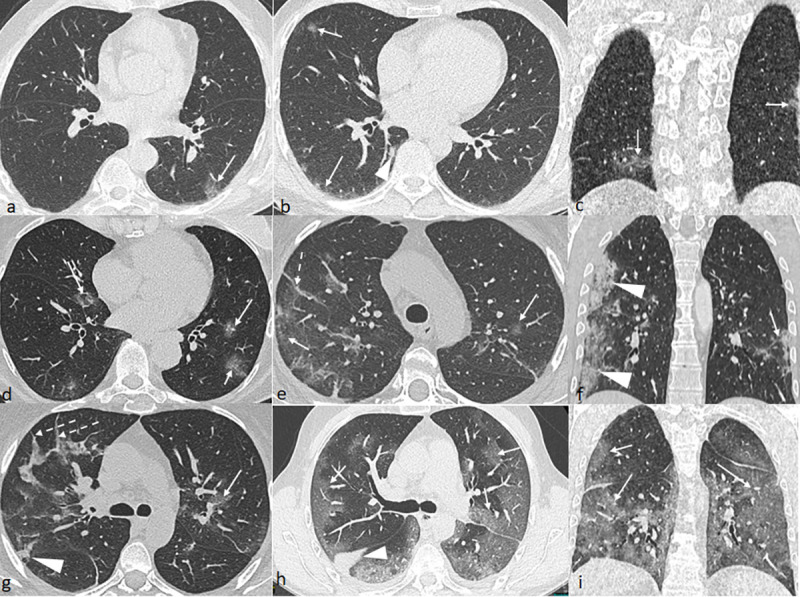
Chest CT of patients with laboratory-proven COVID-19 pneumonia and paucisymptomatic patients.Minimal form (a-c): Axial (a,b) and frontal reconstructions (c) of patchy ground-glass opacities (white arrows) with segmental parenchyma involvement of 1 to 3 patchy lesions. Intermediate form (d-f): Axial (d,e) and frontal reconstructions (f) of patchy ground-glass opacities (white arrows), band-like appearance (dotted arrow), and areas of consolidation (arrowheads) with involvement less than 50%. Severe form (g-i): Axial (g,h) and frontal reconstructions (i) of patchy ground-glass opacities (white arrows), band-like appearance (dotted arrow), and areas of consolidation (arrowheads) with an involvement greater than 50%.